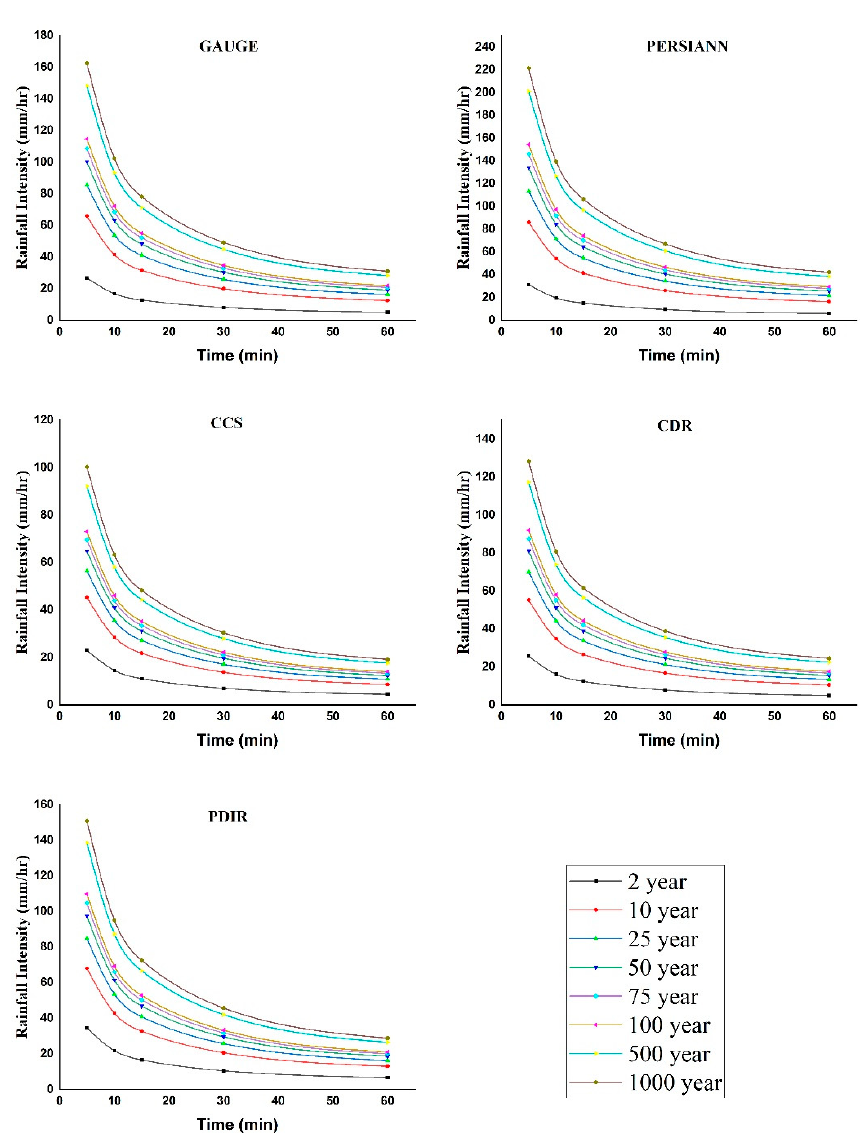
Figure A1. IDF curves for satellite products vs. rain gauge data based on study duration.